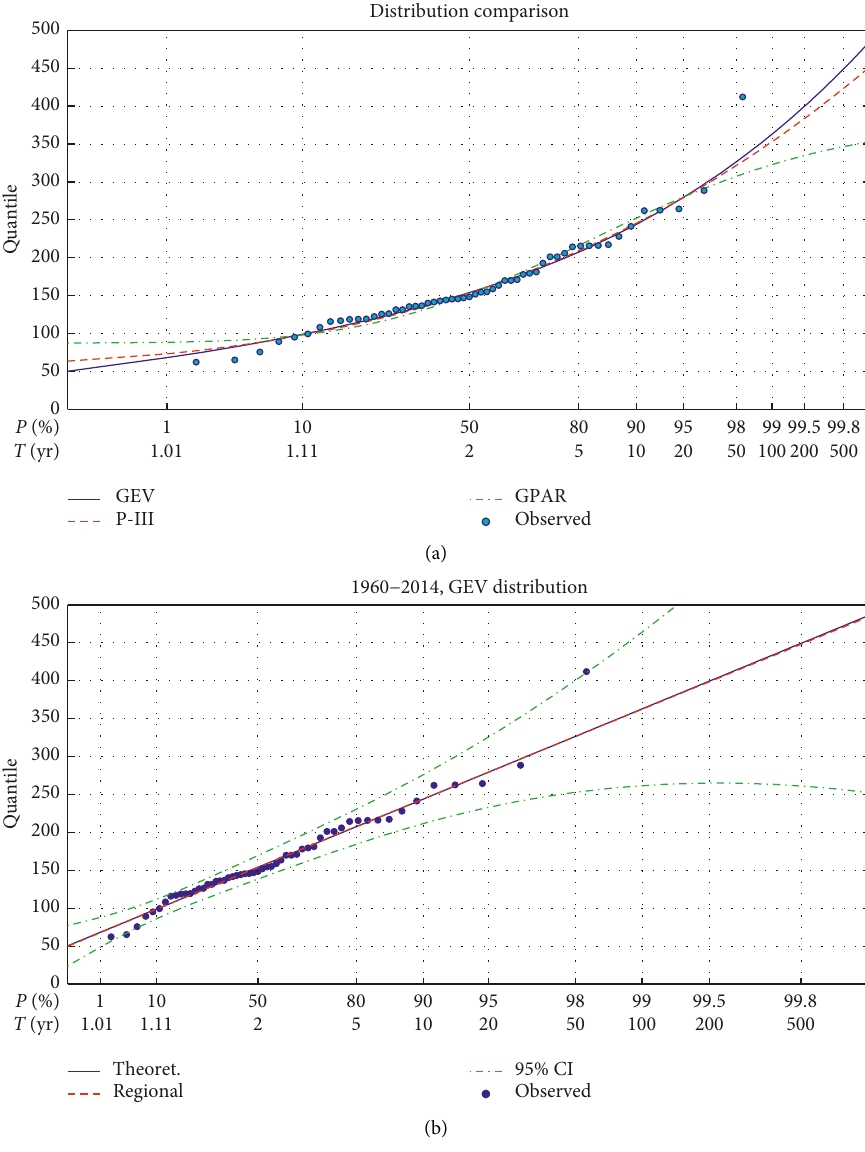
Figure 10: (a) Comparison of fitting curves of GEV, P-III, and GPAR. (b) Observed and estimated PX10D in Shangqiu Station based on regional and at-site